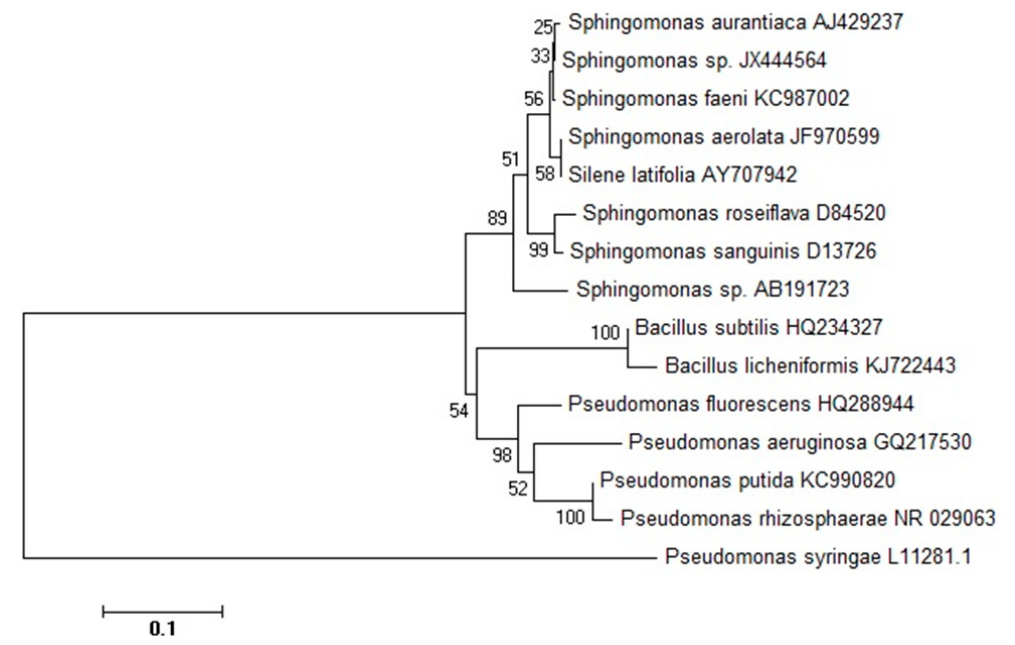
Figure 2. A phylogenetic tree created with the use of the neighbor-joining (NJ) method. The NJ method reflects the phylogenetic affinity between the identified bacterial species and Sphingomonas sp. JX444564 (S11). Bacterial isolates were identified based on 16S r RNA gene markers. The statistical significance of the tree was determined in the bootstrap test with 2000 replicates and > 70% bootstrap